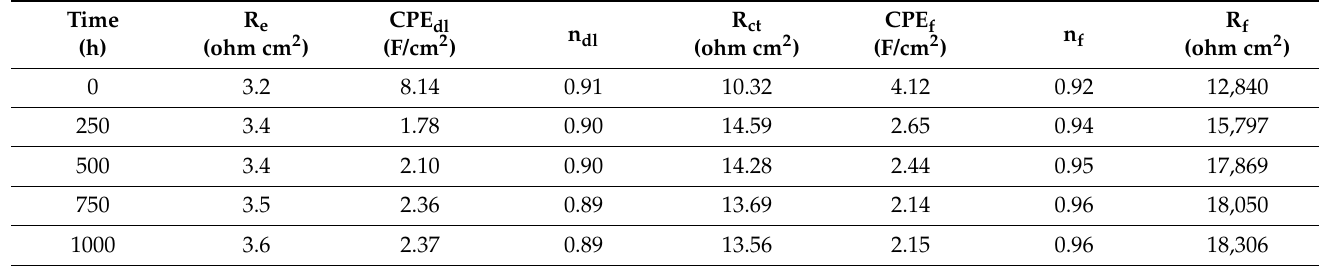
Table 2. Electrochemical parameters obtained from the fitting of the EIS data at 300 ◦ C.